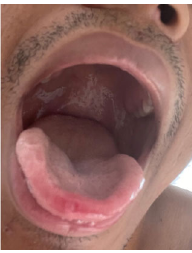
Figure 2. Peeling of the mucosa following acute pharyngitis and monkeypox ‐ associated ulcer at the tip of the tounge.